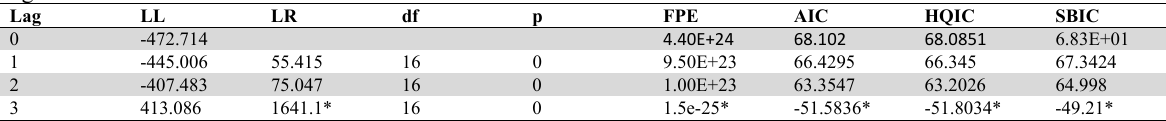
Lag selection test